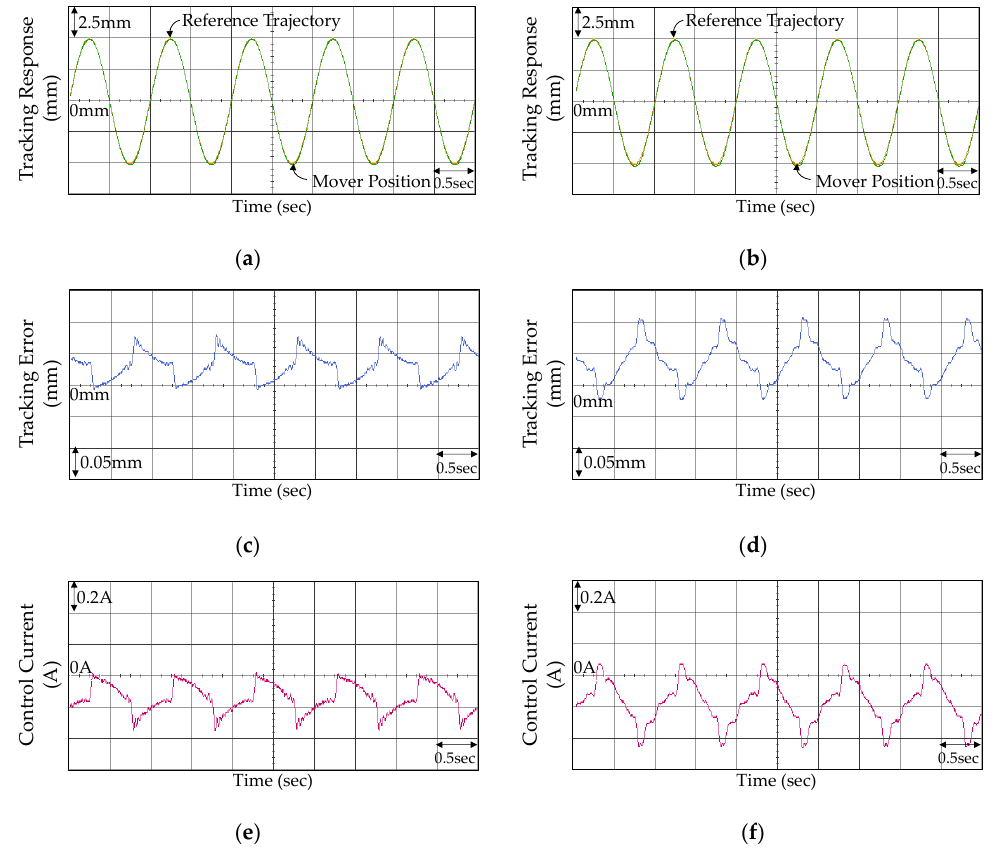
Figure 7. Experimental results of the VCM control system using the FOPID controller: ( a ) tracking response in Case 1; ( b ) tracking response in Case 2; ( c ) tracking error in Case 1; ( d ) tracking error in Case 2; ( e ) control current in Case 1; and ( f ) control current in Case 2.